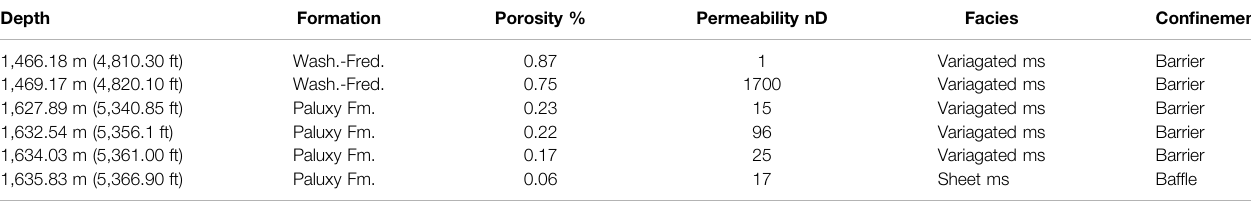
TABLE 3 | Barriers and baf fl es (MPC